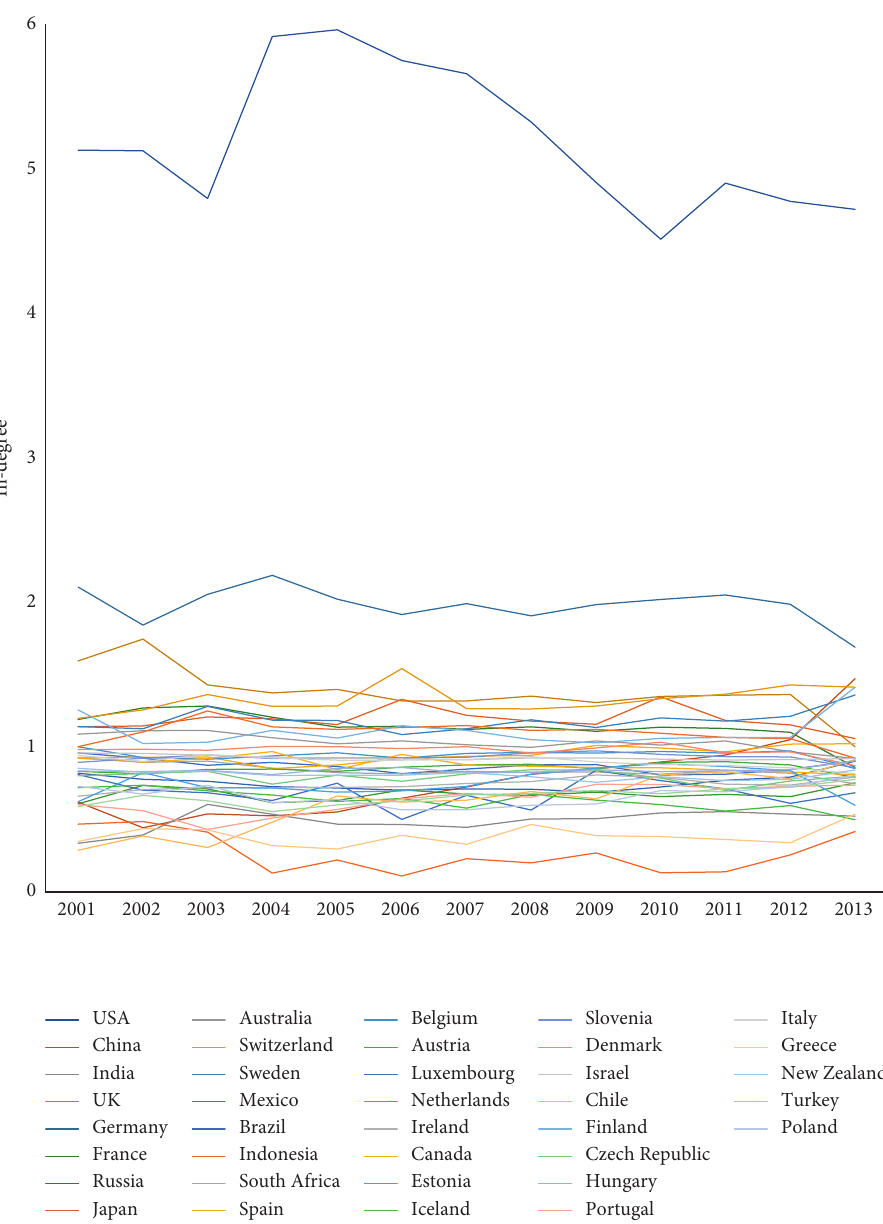
Figure 2: Evolutions of in-degrees of the chosen countries from 2001 to